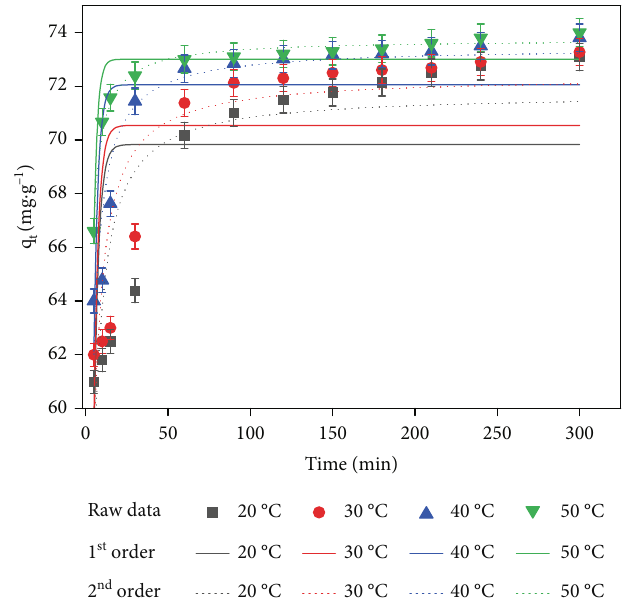
Figure 9: Nonlinear regression plots of pseudo- fi rst-order and pseudo-second-order kinetics for the adsorption of BF dye on TKC at di ff erent